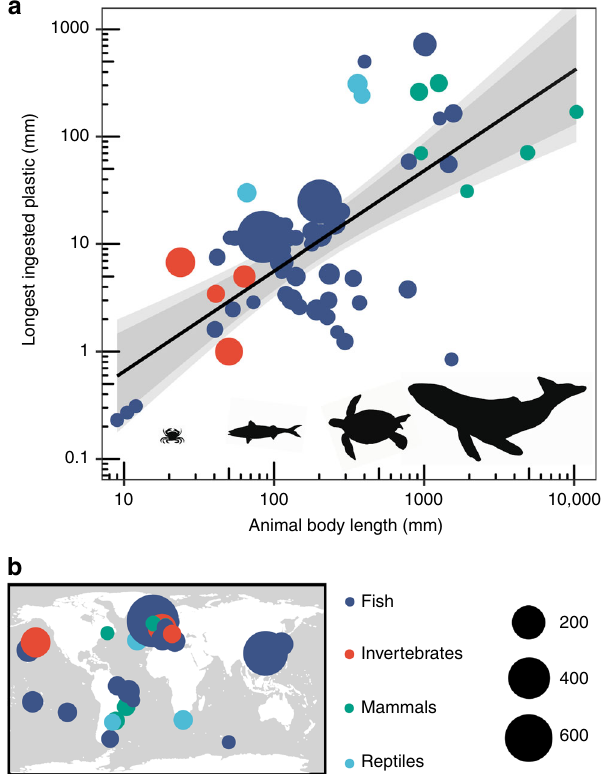
Fig. 1 Allometric relationship between animal size and ingestible plastic size. a Allometric size relationship (log10-log10 linear regression; R 2 = 0.42, F 1,63 = 46.06, p = 4.7e − 09 ), including 99% (light grey) and 95% (dark grey) CIs, between animal body length (mm) and the longest piece of ingested plastic (mm) found during gut surveys (longest axis of largest piece of plastic found). Animal images are for illustration only and are not to scale. Each data point ( n = 65) corresponds to the largest piece of plastic found within an animal taxon. b Distribution of fi eld studies that provided data for the allometric relationship. Size of data points in a and b correspond to the number of individual animal specimens surveyed. Similar taxa from separate studies are plotted